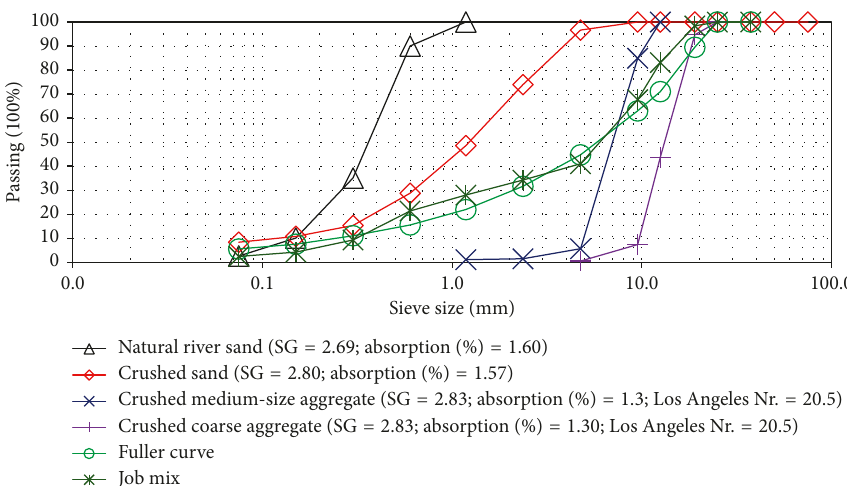
Figure 3: Particle-size distribution of the aggregates with some physical properties.